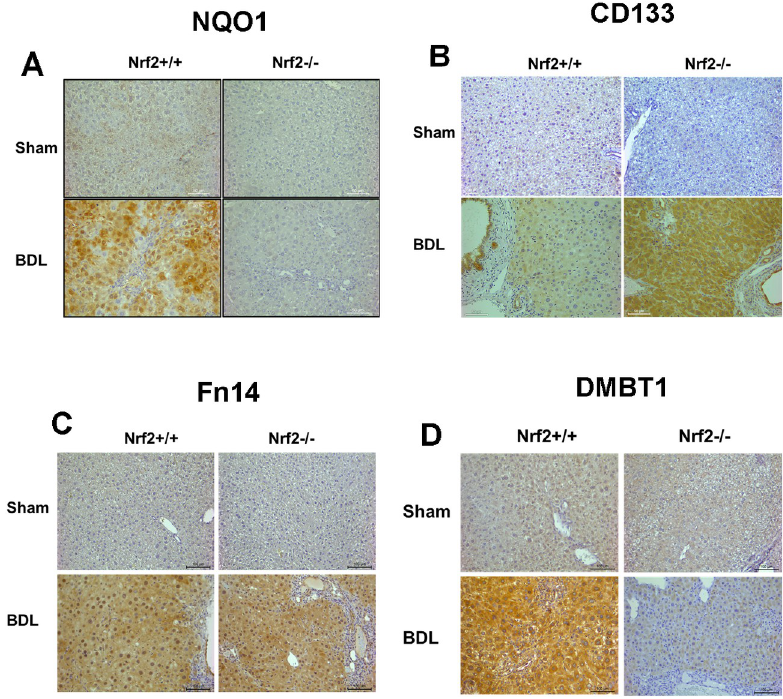
Fig 7. Hepatic distribution of a group of proteins in Nrf2 +/+ and Nrf2 -/- mice post-bile duct ligation (BDL) or sham operation (Sham). Sections prepared from the livers of mice 40 days after BDL or sham operation were subjected to (A) NQO1, (B) CD133, (C) Fn14, and (D) DMBT1 immunostaining. Representative sections are shown.